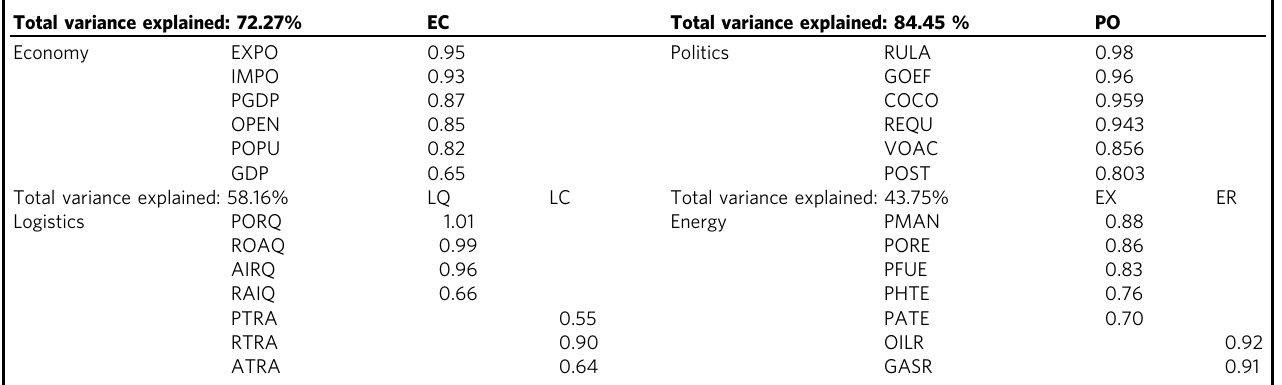
Table 4 Principal component analysis results. Total variance explained: